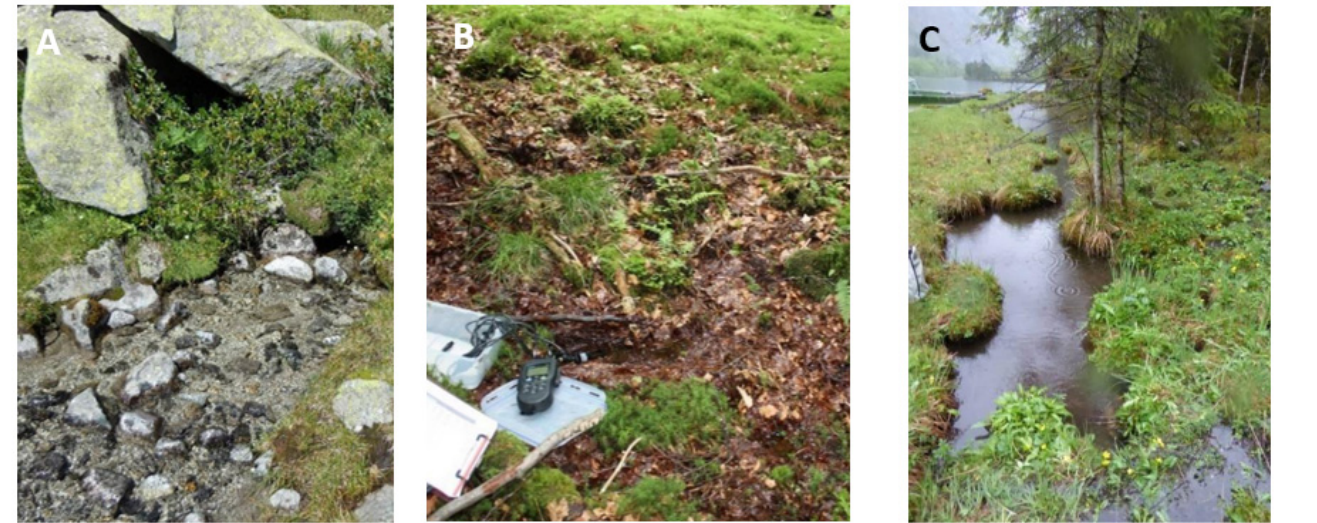
Figure 1. ( A ) Rheocrenic spring in the Adamello-Brenta Nature Park; ( B ) helocrenic spring in the Bavarian Forest National Park; ( C ) limnocrenic spring the Berchtesgaden National Park.